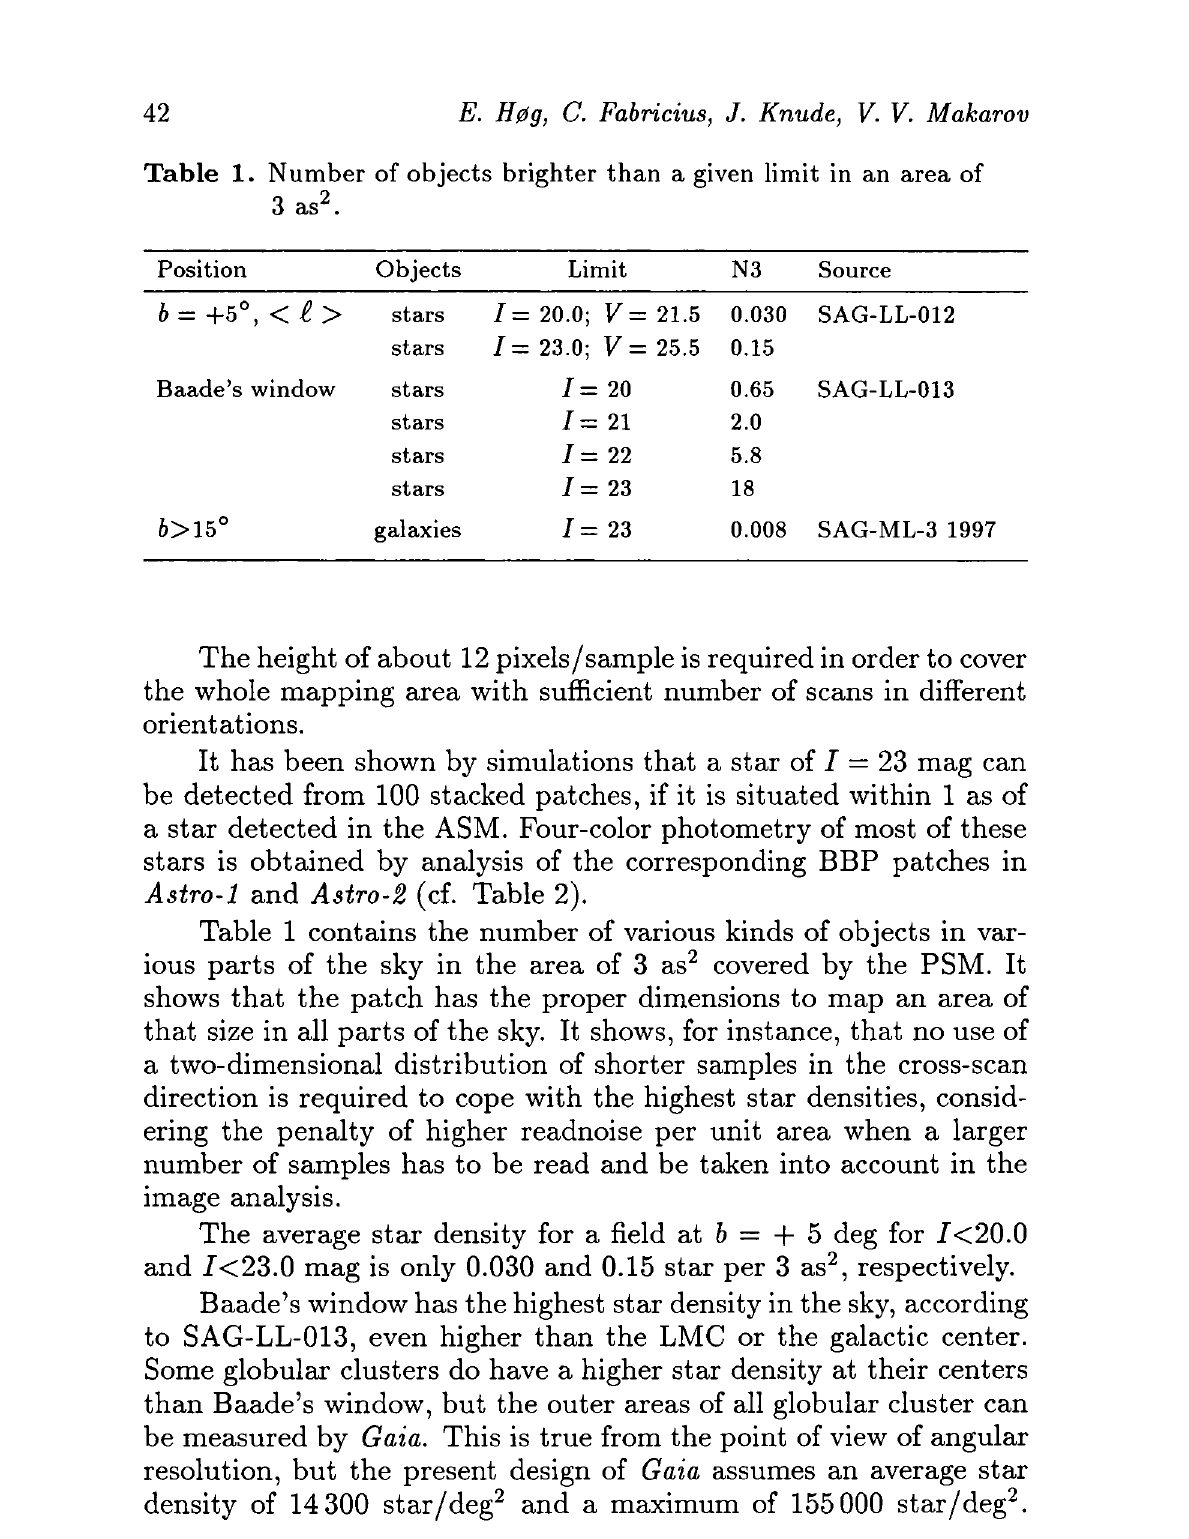
Table 1. Number of objects brighter than a given limit in an area of 3 as 2